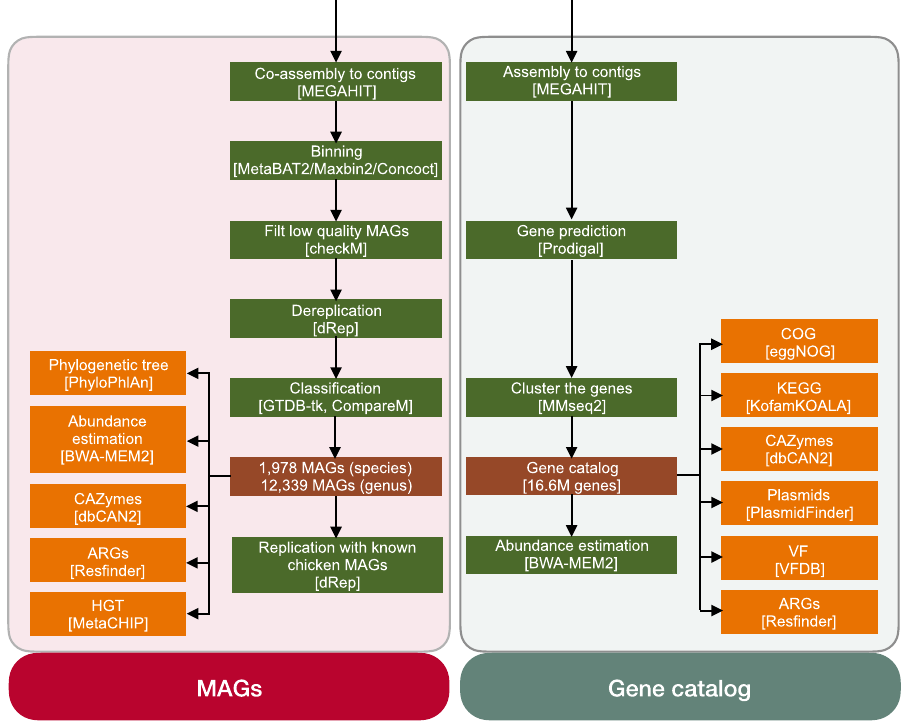
Fig. 1 Flowchart of the steps and bioinformatic tools applied in assembling, constructing, annotating, and analyzing the reference genomes and microbial gene catalog. Metagenomic sequencing data from the 799 chicken gut microbiome samples from ten countries were integrated. The MAGs (more than 80% completeness and less than 10% contamination) were clustered to strain-level and species-level genome bins at 99% and 95% ANI, respectively. The phylogenetic tree, CAZymes, ARGs, and HGT of the MAGs were analyzed further. The complete genes were clustered to generate the 16.6-million nonredundant gene catalog. Functions of the genes were annotated to pro fi le CAZymes, virulence factors, and plasmid patterns in the chicken gut